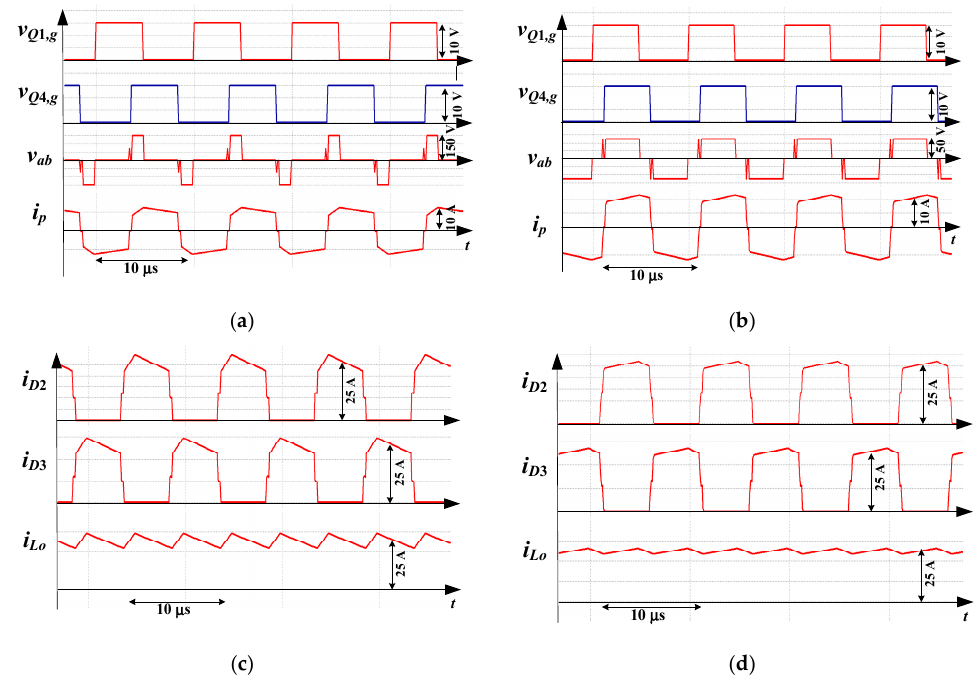
Figure 6. Simulated results in high input voltage range and full load ( a ) primary side waveforms at 150 V input ( b ) primary side waveforms at 50 V input ( c ) secondary side waveforms at 150 V input ( d ) secondary side waveforms at 50 V input.